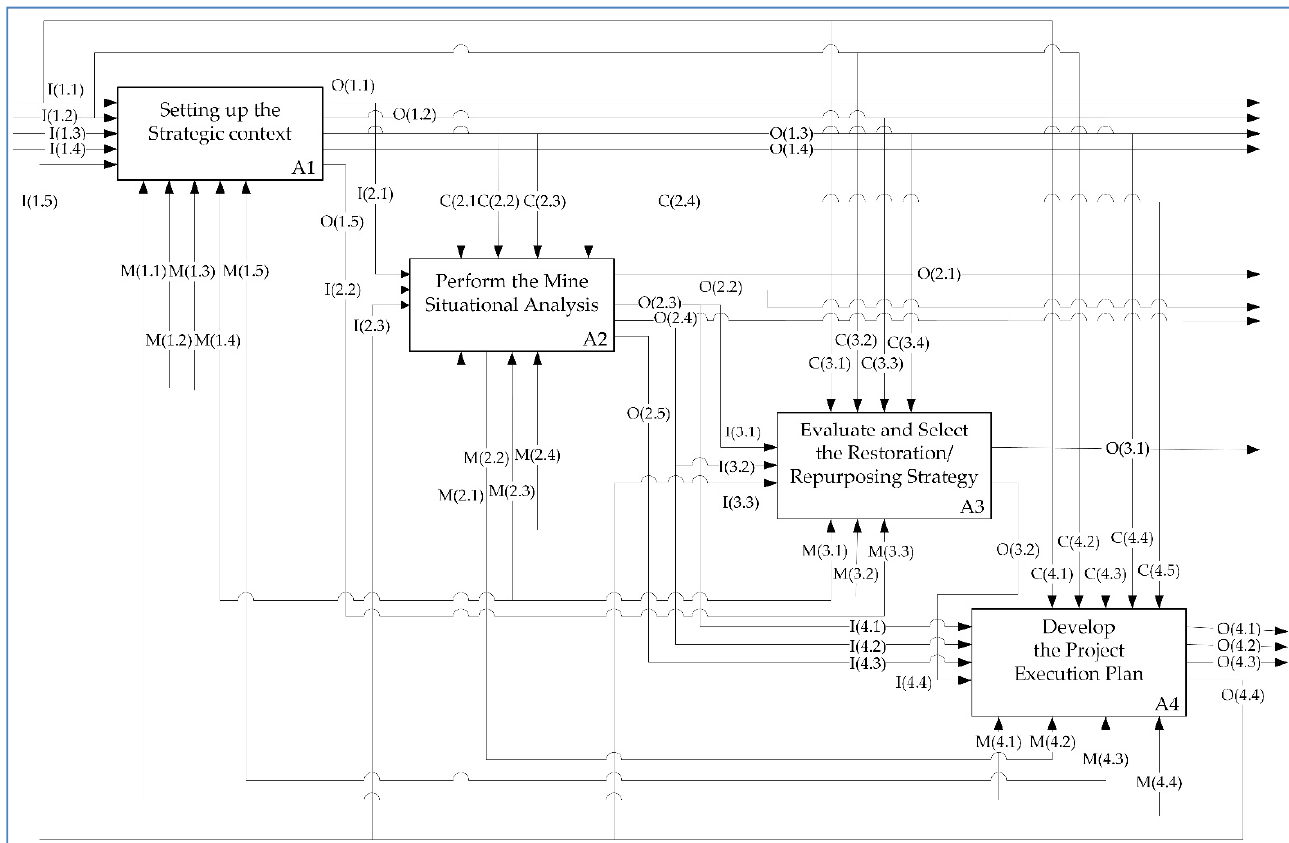
Figure 1 . The A-0 concept diagram “Post-Mining Restoration/Repurposing Strategic Planning”.